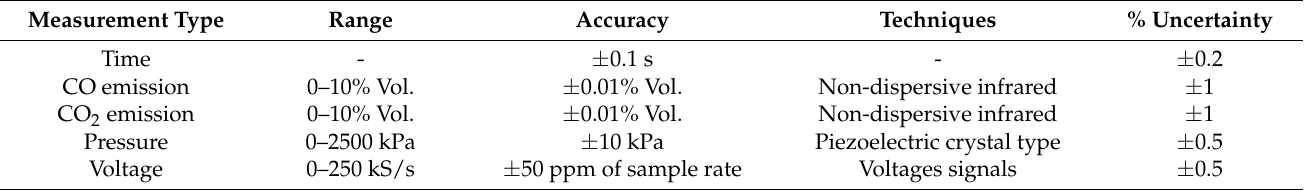
Table 3. The type, range, accuracy, technique and percentage of uncertainty of the measuring equipment.